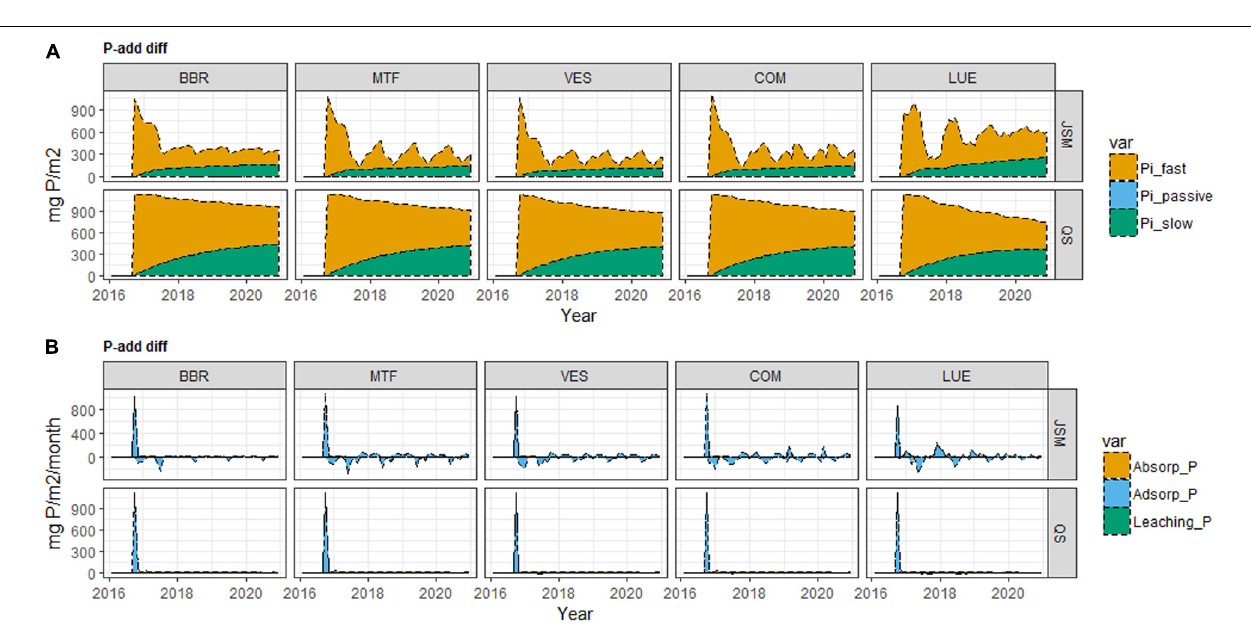
FIGURE 4 | Simulated changes of (A) N budget after N addition (N-add) and (B) P budget after P addition (P-add) in JSM and QUINCY-soil (QS) at the study sites along the soil P gradient (BBR > MTF > VES > COM > LUE). The proposed processes for the N budget are: N fixation, SON change, N leaching, and plant N uptake; the proposed processes for P budget are: SIP change, SOP change, P leaching, and plant P uptake.